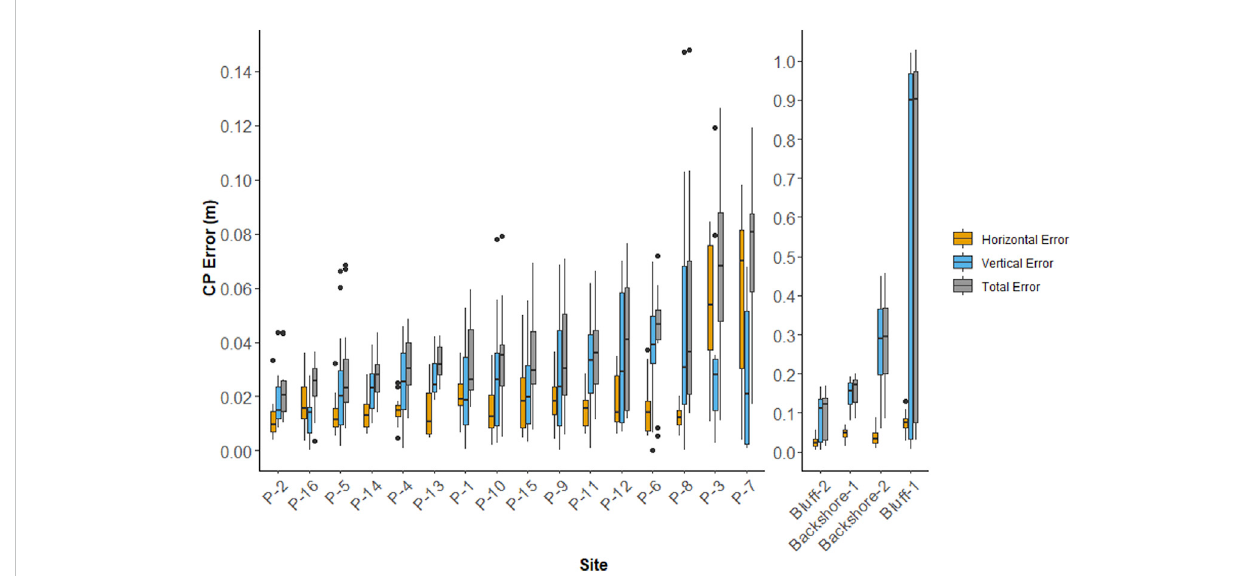
FIGURE 4 Distribution ofcheck pointerrormagnitudes (m)for allsitesinthehorizontal(orange), vertical(blue), andtotal(grey) directions. Boxesrepresentthe interquartilerange(IQR),whiskersrepresentpoints < 1.5*(IQR)above orbelowtheIQR,anddots represent points > 1.5*(IQR) aboveorbelowtheIQR.The leftmost16sites(P-1àP-7)plottedusingtheleft Y -axisfrom0.00 – 0.15 mwhilethe4sitesontheright(Bluff-1àBluff-2)areplottedusingtheright Y -axis from 0.0 – 1.0 m.